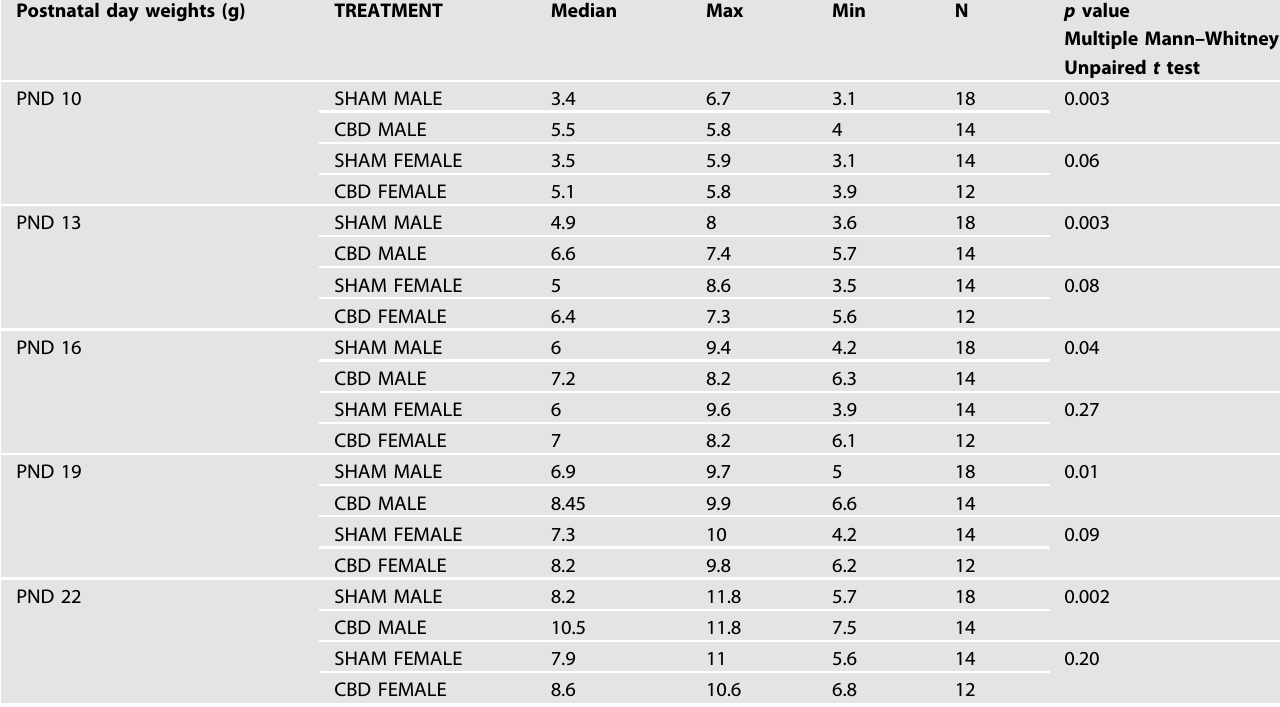
Table 1. Cannabidiol prenatal exposure increases pup weights in a sex-speci fi c way. Postnatal day weights (g)